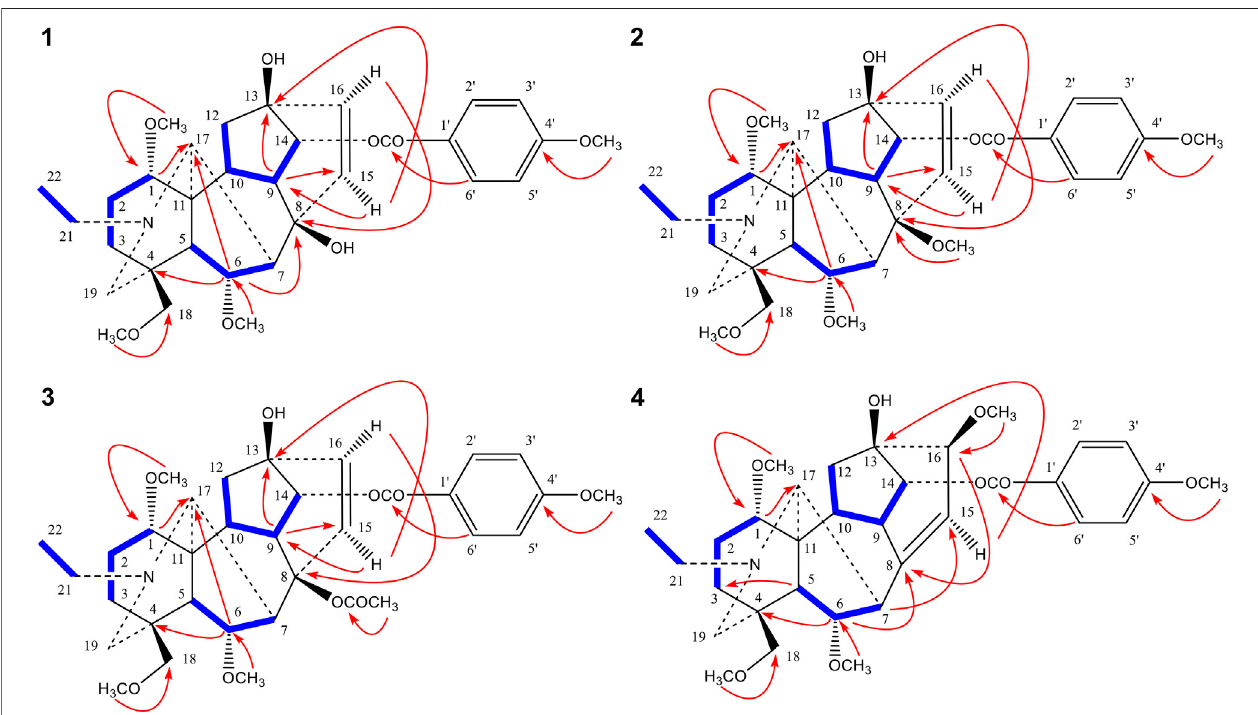
FIGURE 4 | Key NOE correlations (H ↔ H) of compounds 1 – 4 .